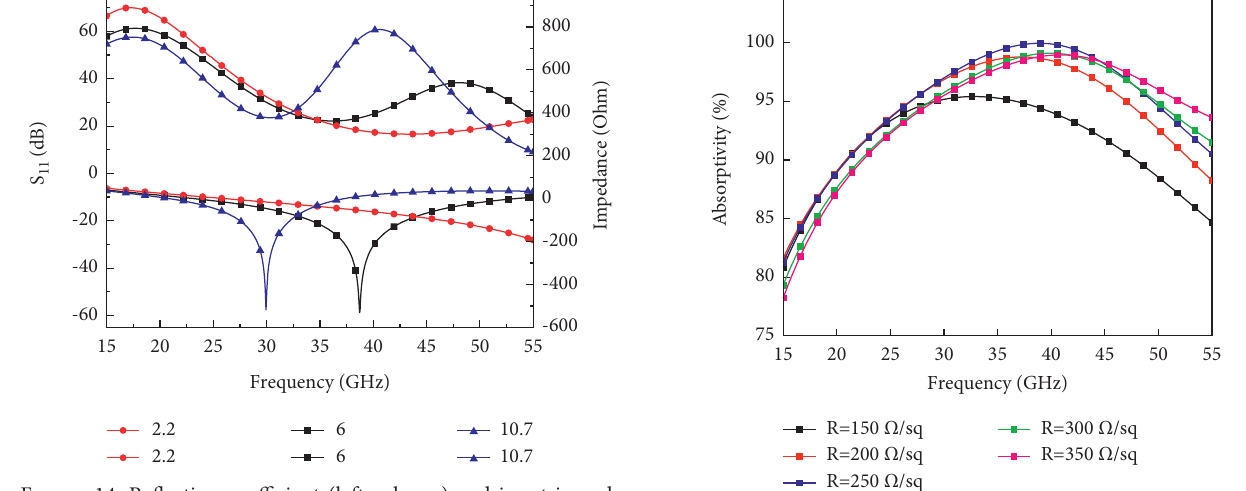
Figure 16: The absorptivity with different square resistance.